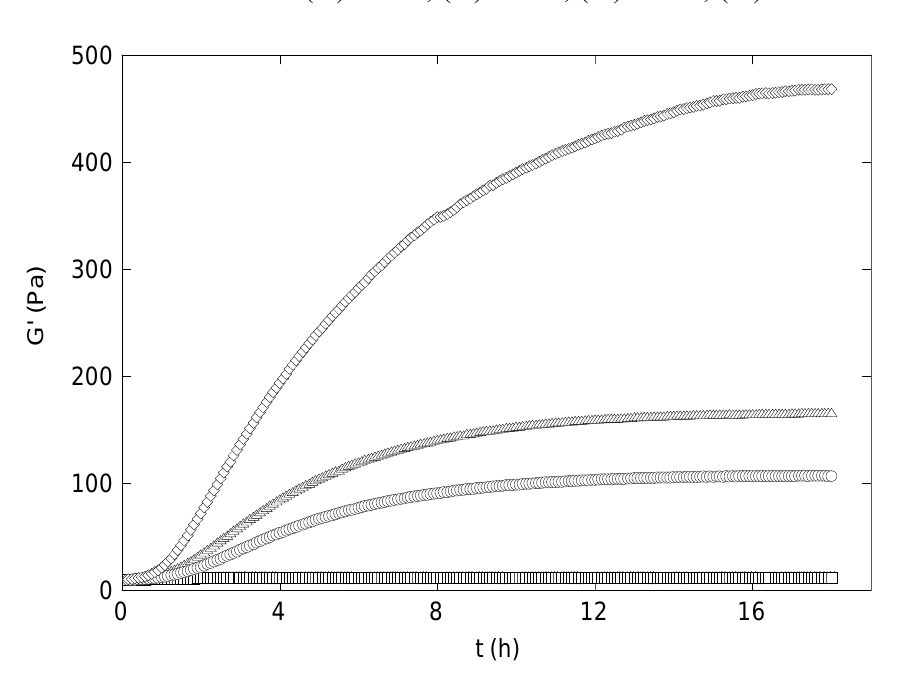
Figure 4. Kinetics of the cross-linking of xanthan-KGM mixture by epichlorohydrin. Initial cross-linker concentration: (  ) 0.1 M; (  ) 0.3 M; (  ) 0.6 M; (  ) 1.4